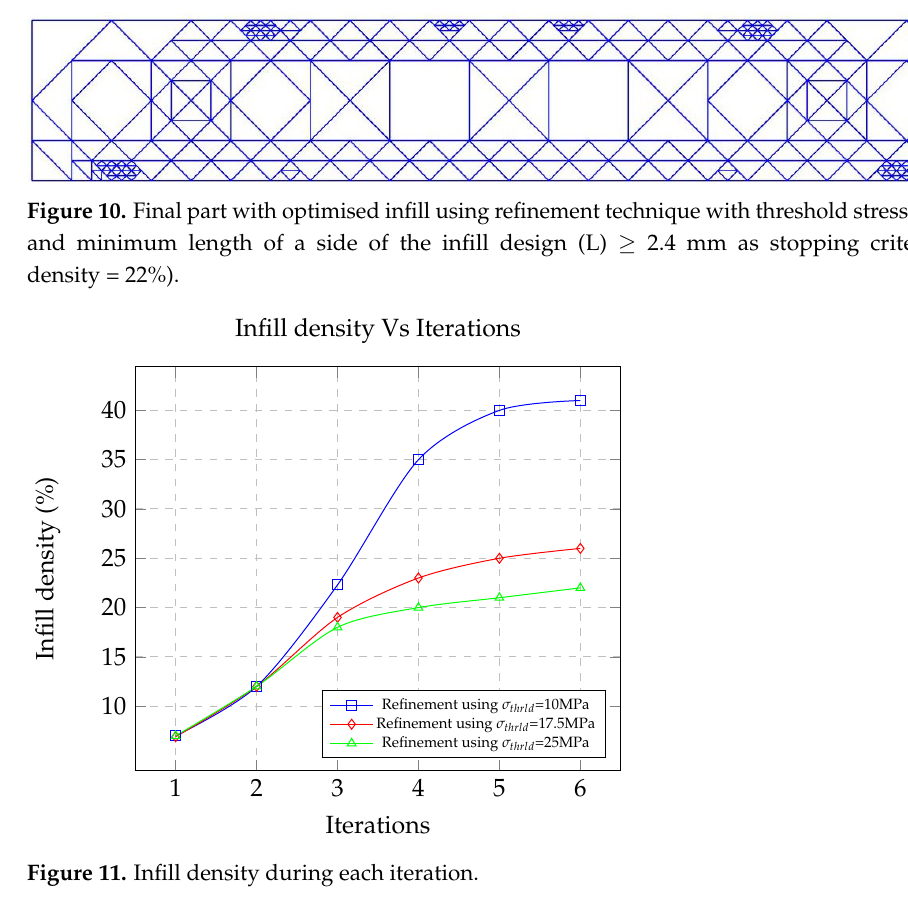
Figure 9. Final part with optimised infill using refinement technique with threshold stress = 17.5 MPa and minimum length of a side of the infill design (L) ≥ 2.4 mm as stopping criteria (infill density = 26%).